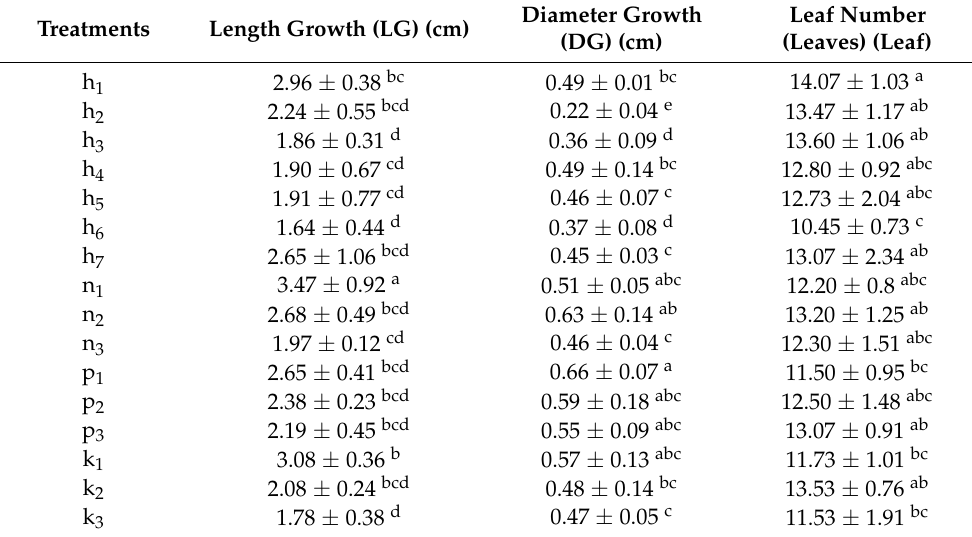
Table 2. Growth index of jujube fruiting branch under different fertilization treatments (mean ± SD, n = 45). One tree was measured for 15 fruit branches, with 3 trees having 45 replicates. Mean totals with a common letter are not different ( p < 0.05) by ANOVA for the ranking test.